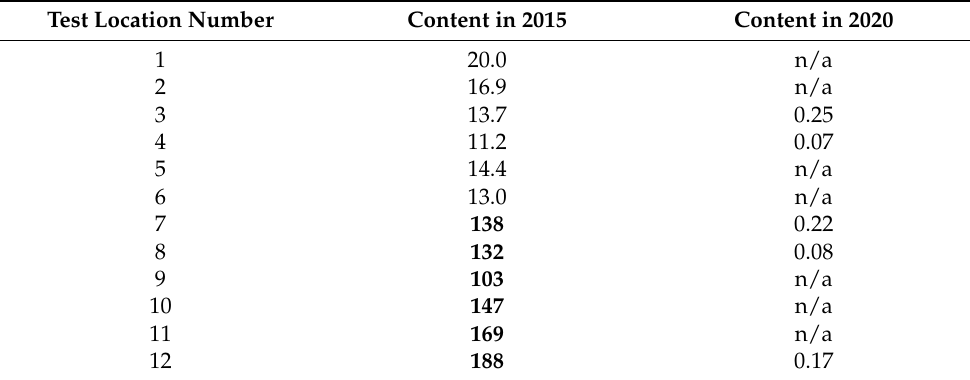
Table 2. Changes in phenol content (mg kg − 1 DM) in the soil prior to (2015) and after the completion of enhanced natural attenuation (2020).